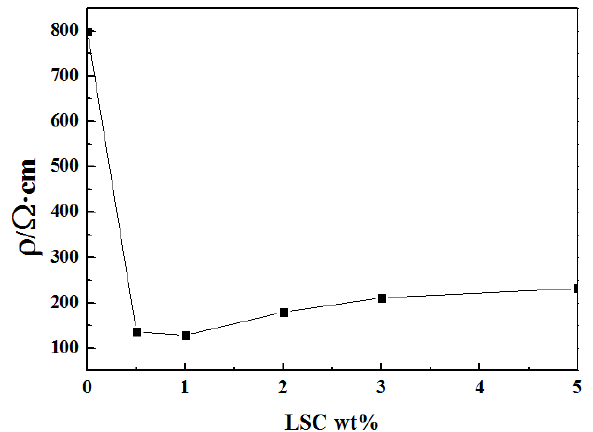
Figure 9. Resistivity curves of semiconductive materials with different LSC contents at 383 K.